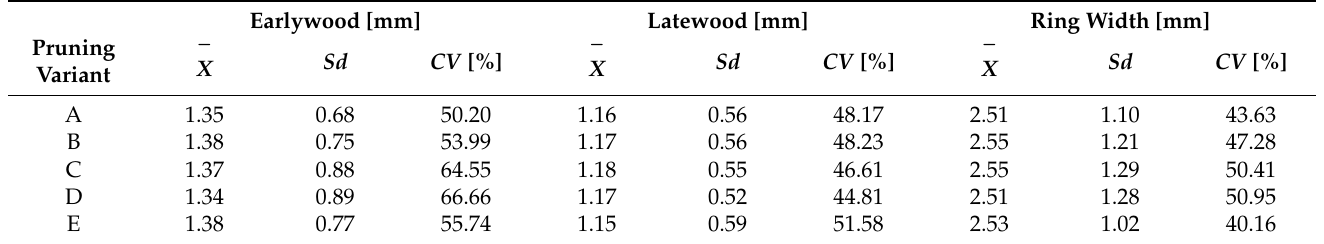
Table 2. Summary of tree increment of analysed Scots pines ( Pinus sylvestris L.) by pruning variant before pruning treatment started (before stand age of 15 years). X is arithmetic mean; Sd is standard